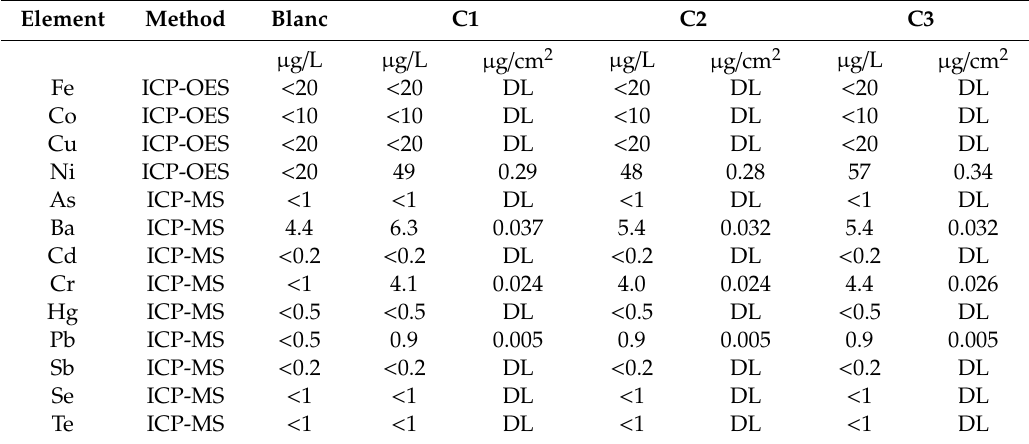
Table 5. ICP analysis results in the artificial sweat extraction solution. DL: Detection limit.